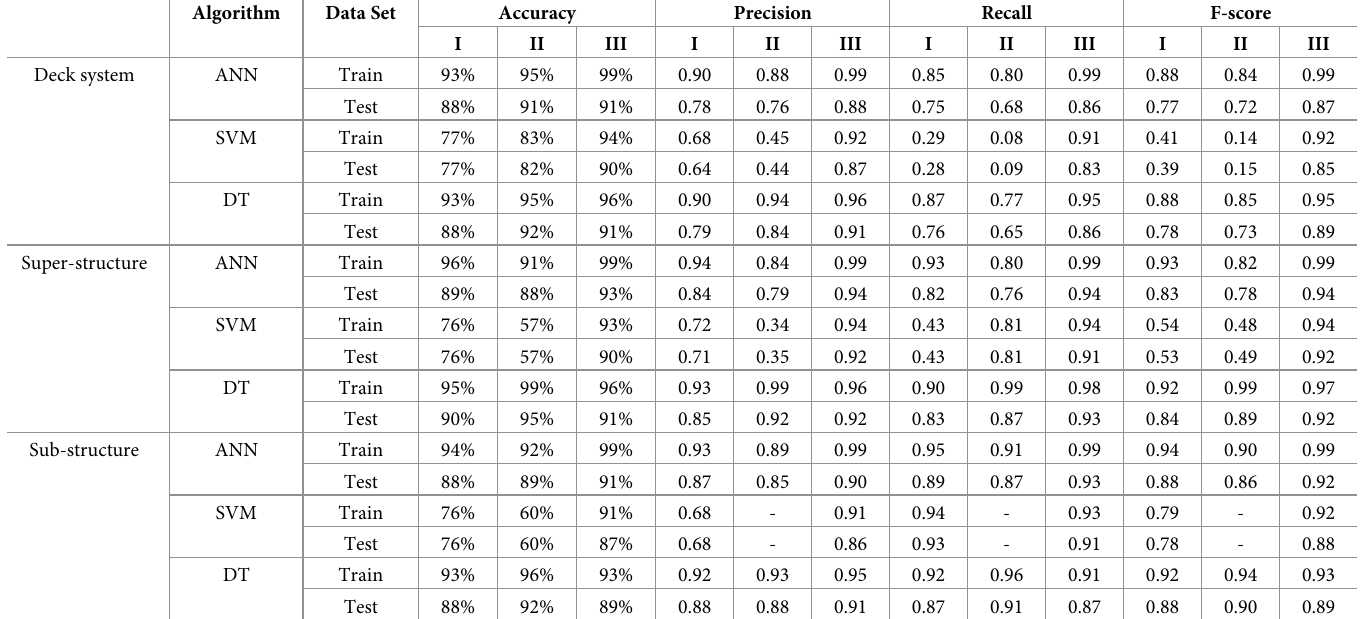
Table 5. Evaluation results of ML prediction model for concrete beam bridge.